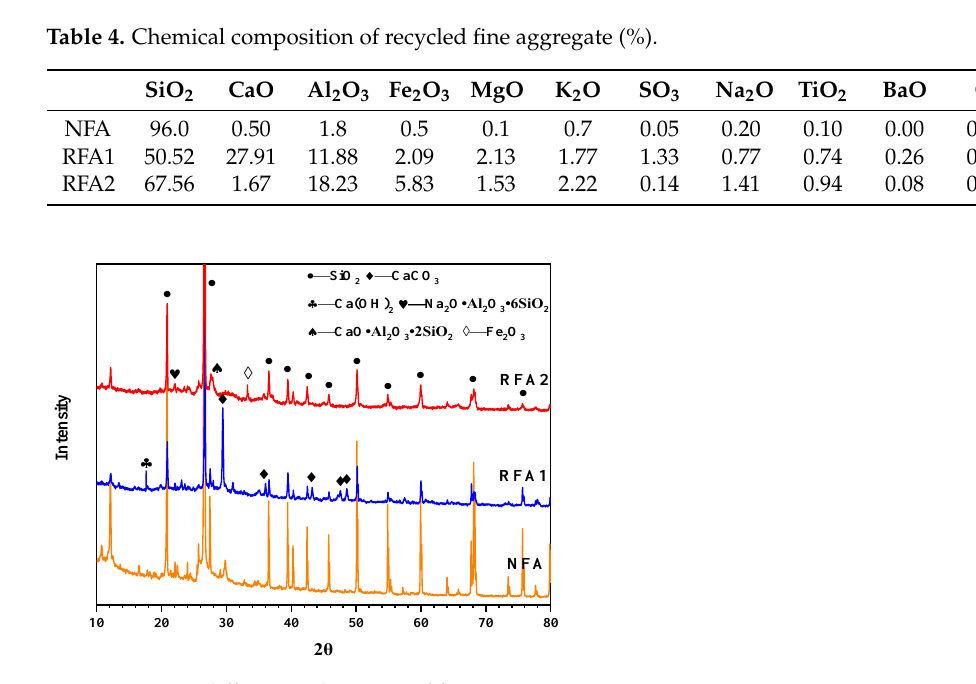
Figure 3. SEM images of ( a ) NFA, ( b ) RFA1 and ( c ) RFA2.